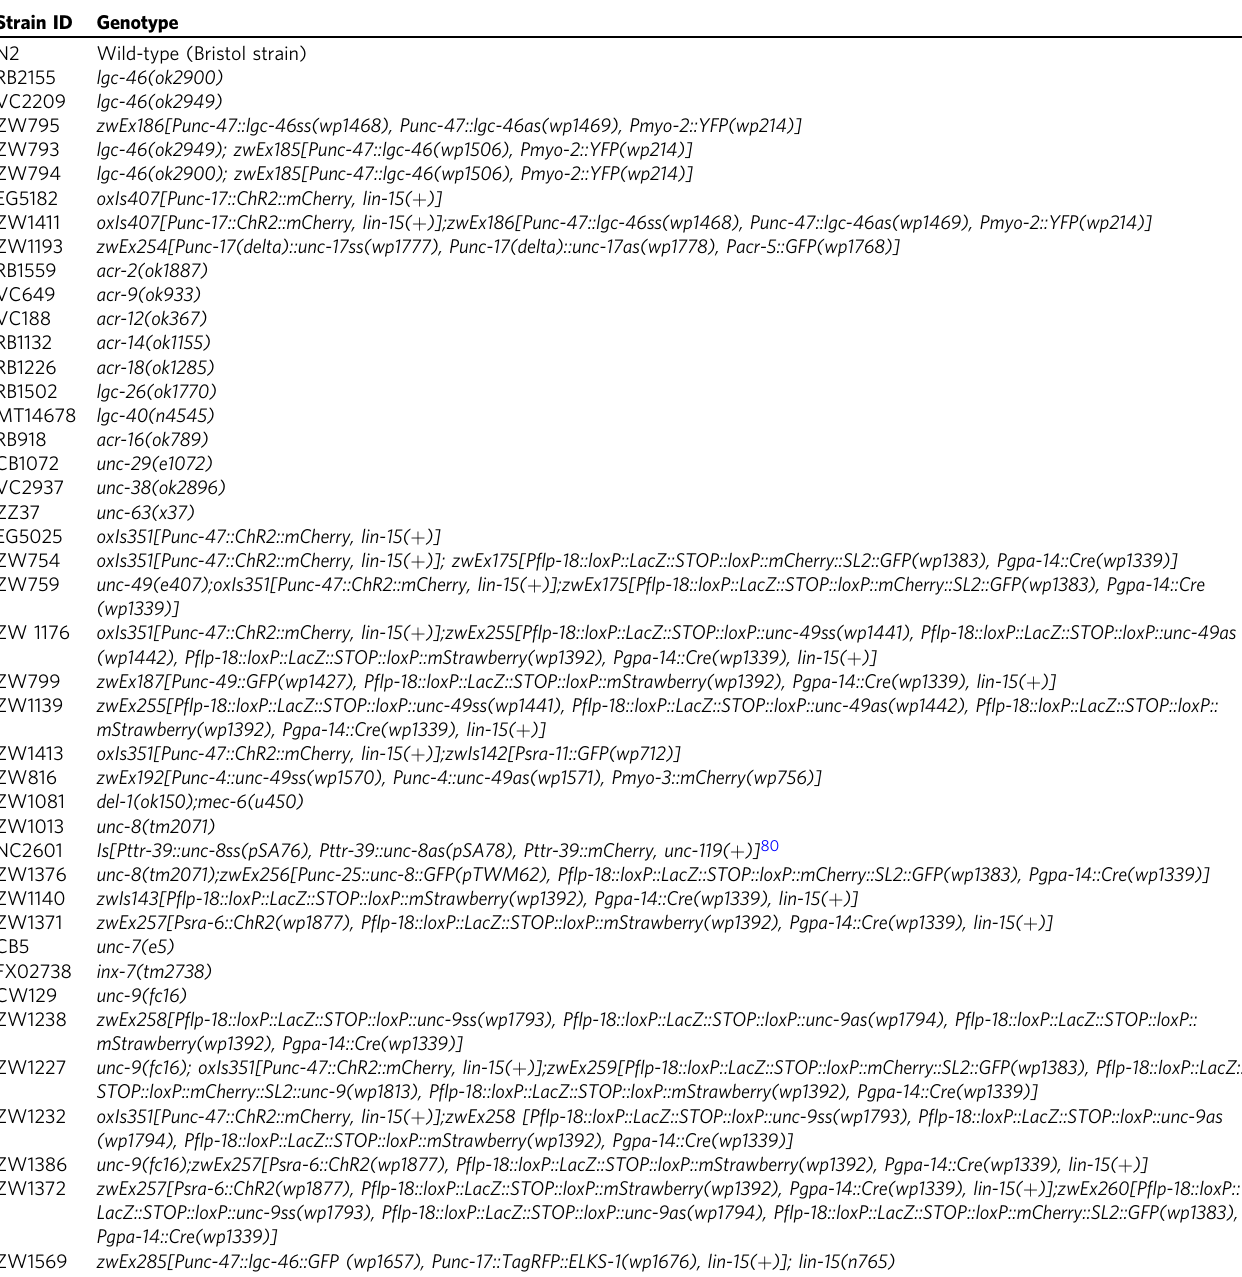
Table 1 List of worm strains. Strain ID Genotype